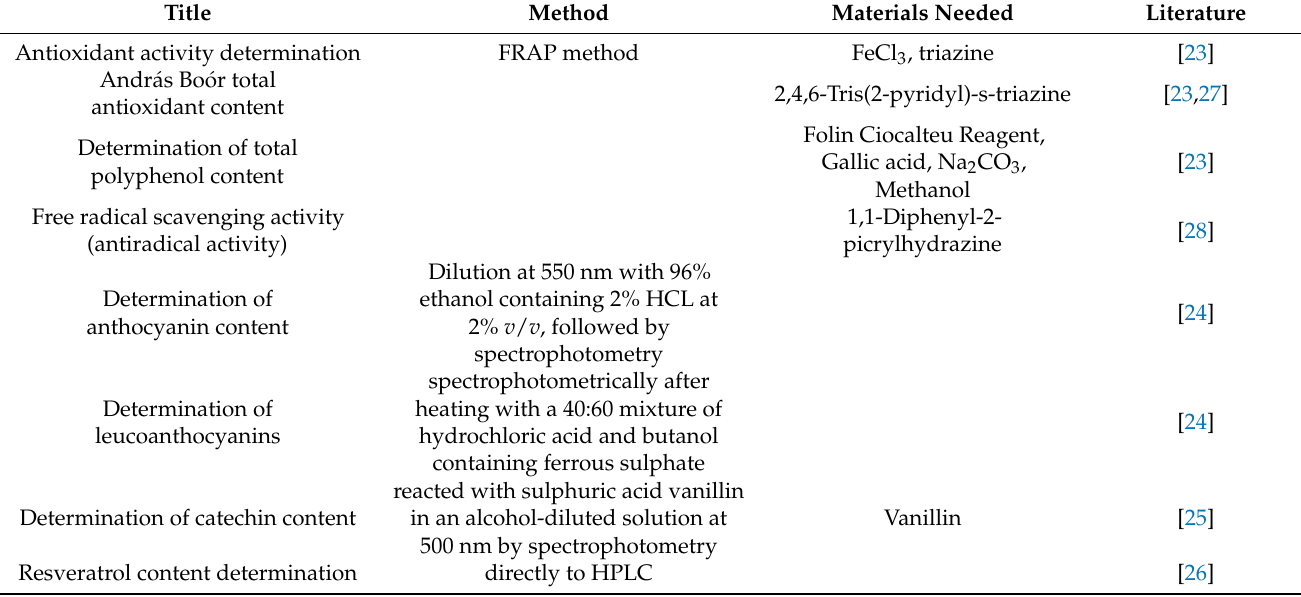
Table 4. Methods used for the determination of antioxidant